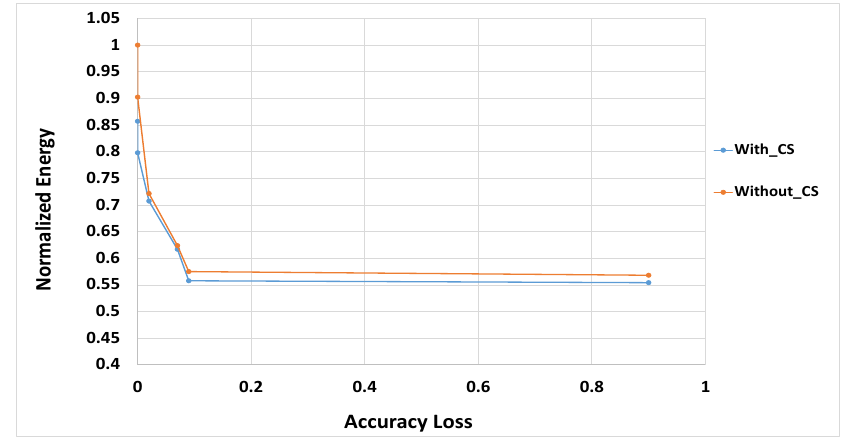
Figure 9. Effect of computation skipping on the accuracy versus consumed